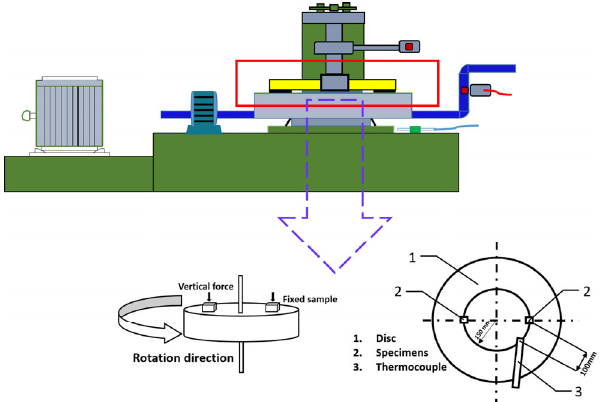
Fig. 3 Schematic of the friction tester showing the installation position of the